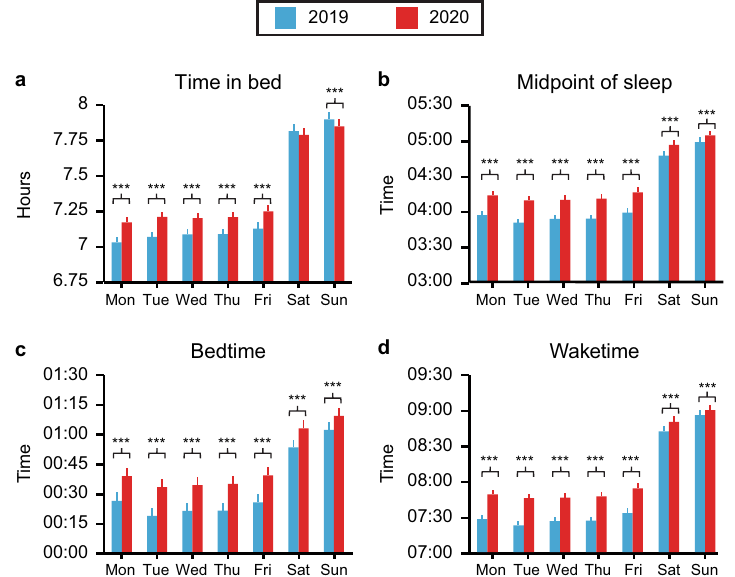
Figure 4. Self-reported time in bed and sleep timing by day of the week during the pandemic. Average time- in-bed ( a ) and midpoint of sleep ( b ) were calculated from self-reported bed ( c ) and wake ( d ) times for each day of the week in 2019 (blue) and 2020 (red). Means and SEMs are shown. Bonferroni-adjusted p values for comparisons between each day of 2019 and the corresponding day of 2020 are indicated as follows: * p < 0.05, ** p < 0.01, *** p <